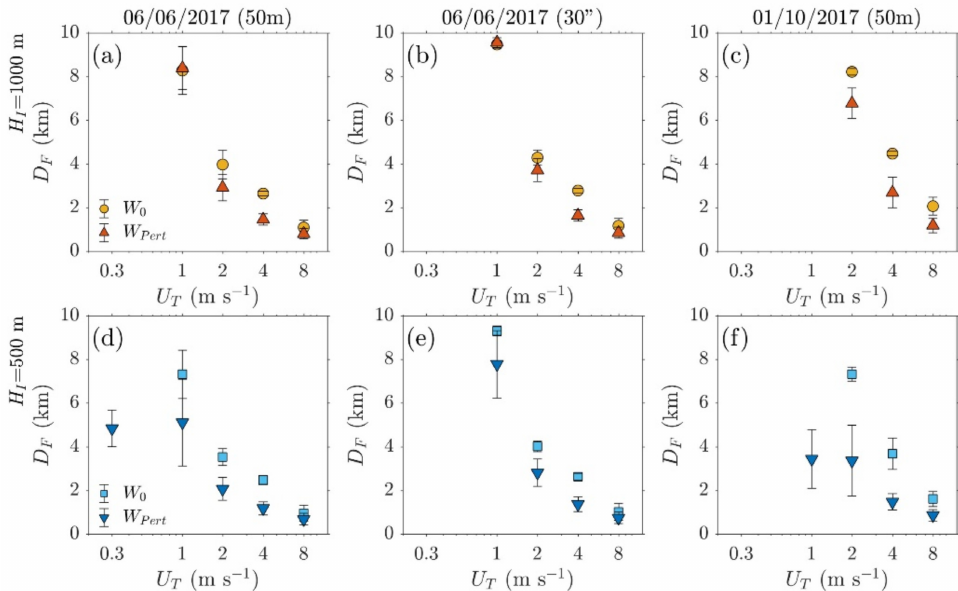
Figure 15. Deposition distance averaged for all particles for the: ( a , d ) June (50 m), ( b , e ) June (30”), and ( c , f ) October (50 m) simulations, for H I = 1000 m (first row) and 500 m (second row). Values using a zero vertical velocity field and the WRF output are shown with different markers. Standard deviation values are shown using error